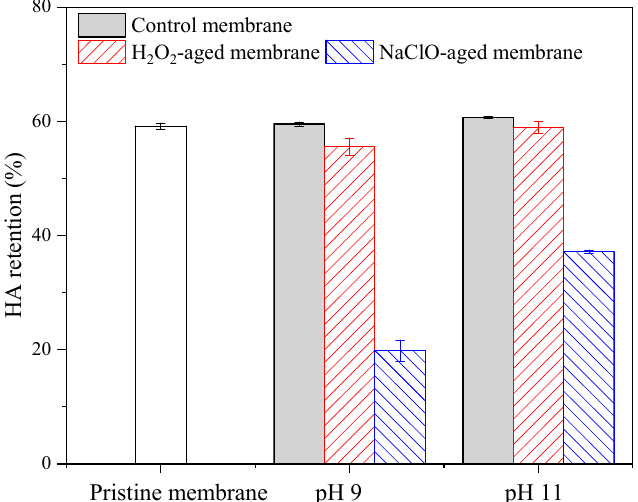
Figure 3. Effects of H 2 O 2 and NaClO aging on HA retention rate of PES membrane. Control membrane indicates membrane samples aged in NaOH solution with pH 9 or 11, c (H 2 O 2 ) = c (NaClO) = 5000 mg/L, t = 100 h, and error bars indicate standard deviation of triplicate samples.